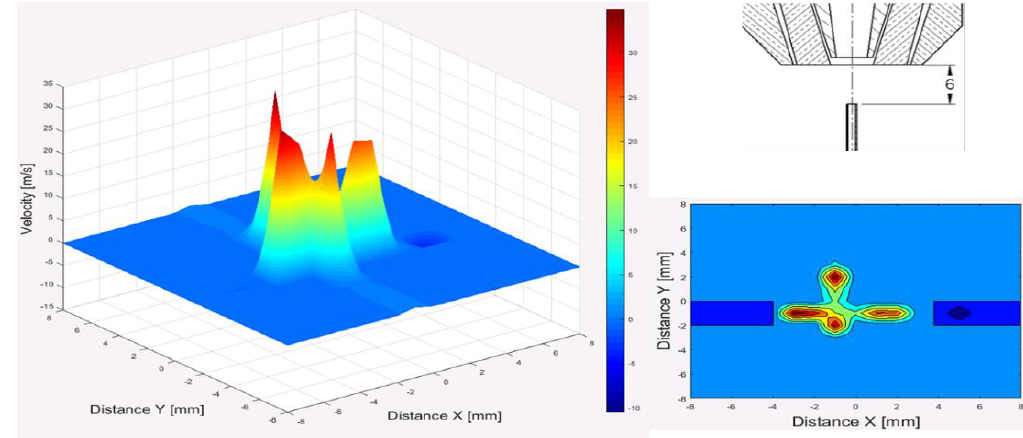
Figure 15: gas velocity measured at 6 mm from the nozzle